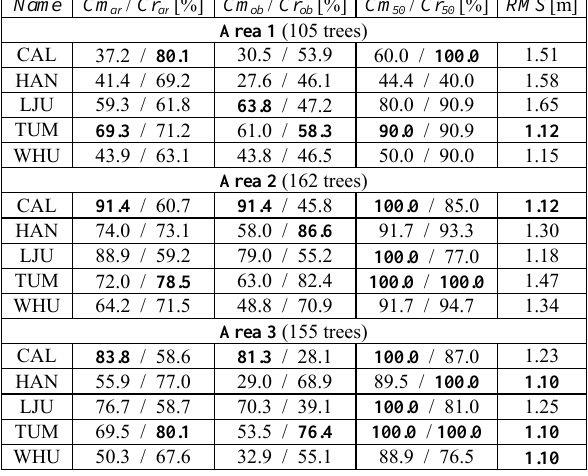
Evaluation of the tree detection results. The column headings are explained in Section